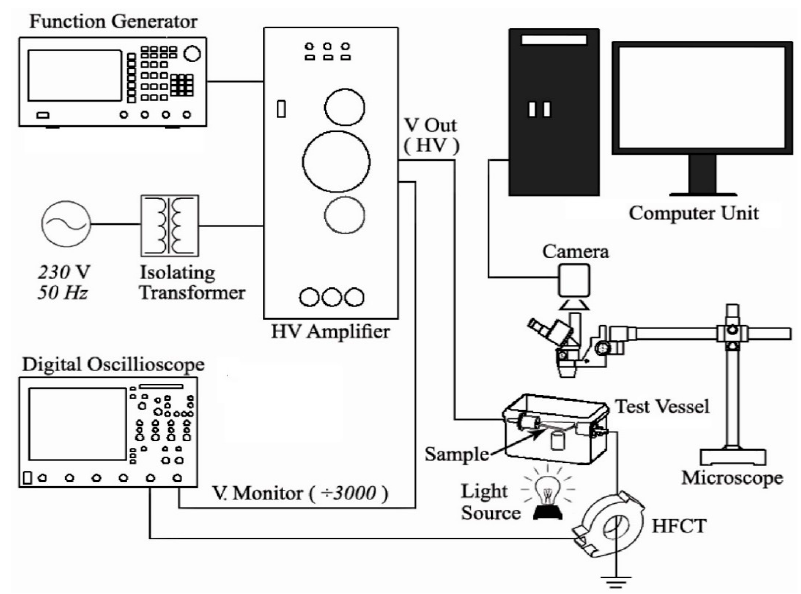
Figure 3. Experiment setup for electrical treeing (ET) optical observation and partial discharge (PD) measurement.